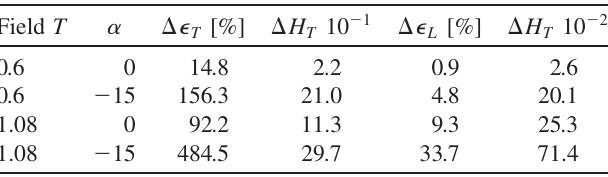
TABLE XVI. Divergence and field dependence in solenoids.